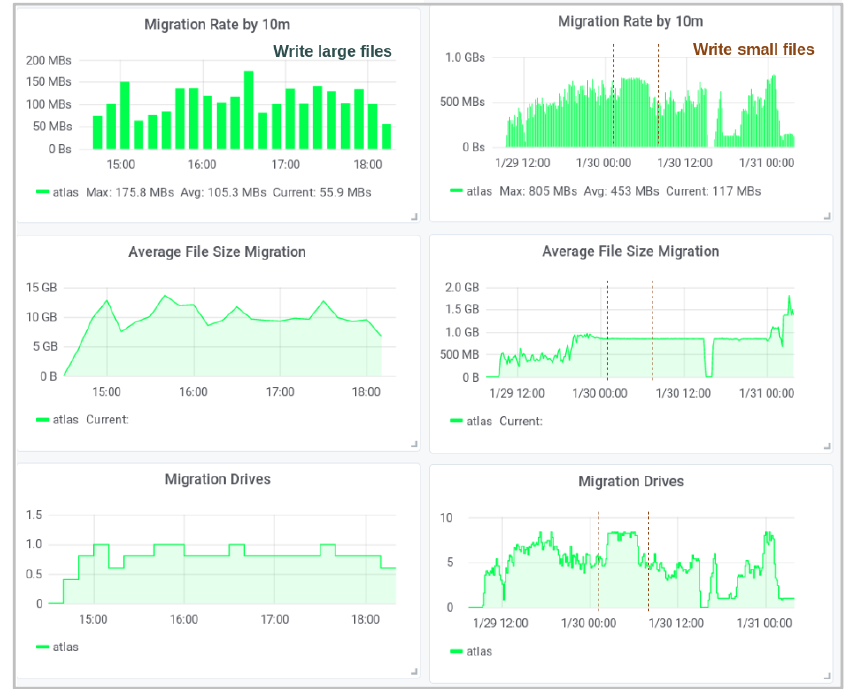
Figure 6: Writing small (less than 1.0GB file size) and large (larger than 9.0GB file size) files to